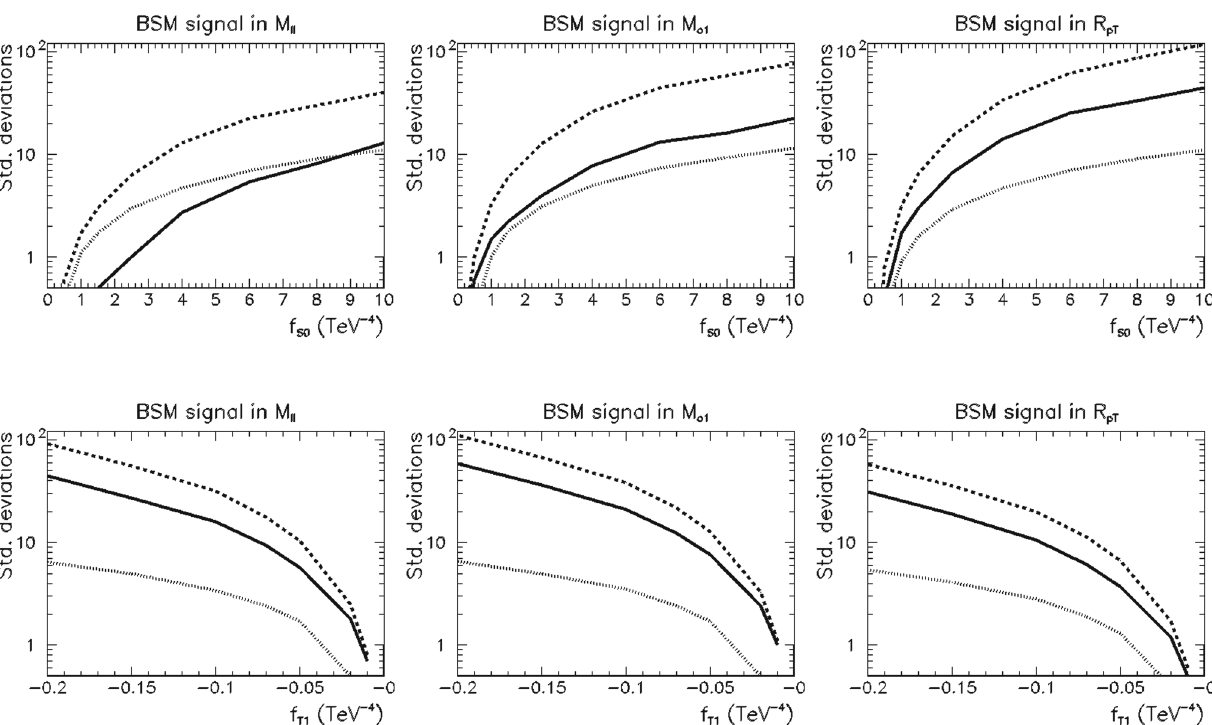
Fig. 3 Typical examples of BSM signal significances computed as a functionof f S 0 (upperrow)and f T 1 (lowerrow)basedondifferentkine- matic distributions. Here the (cid:3) cutoff is assumed equal to the unitarity limit. Shown are predictions obtained by using Eq. (1.8) (solid lines)